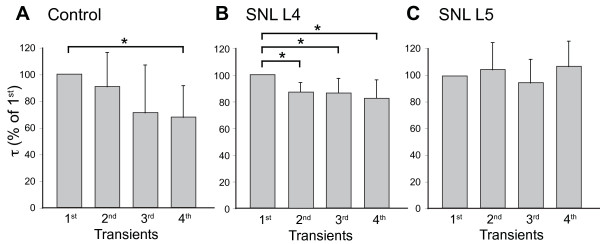
Influence of neuronal activity on PMCA function. The rate constant (τ) for recovery was determined for transients induced at 2 min intervals by application of high K+ solution (50 mM for 0.3 s) in thapsigargin-treated neurons (n = 6). Repeated activation caused progressive acceleration of the recovery in control neurons (A) and neurons from the fourth lumbar dorsal root ganglia after spinal nerve ligation (SNL L4) (B), but not after axotomy in SNL L5 neurons (C). Mean ± SD; * P < 0.05 by repeated measures ANOVA with Dunnett’s post hoc test.